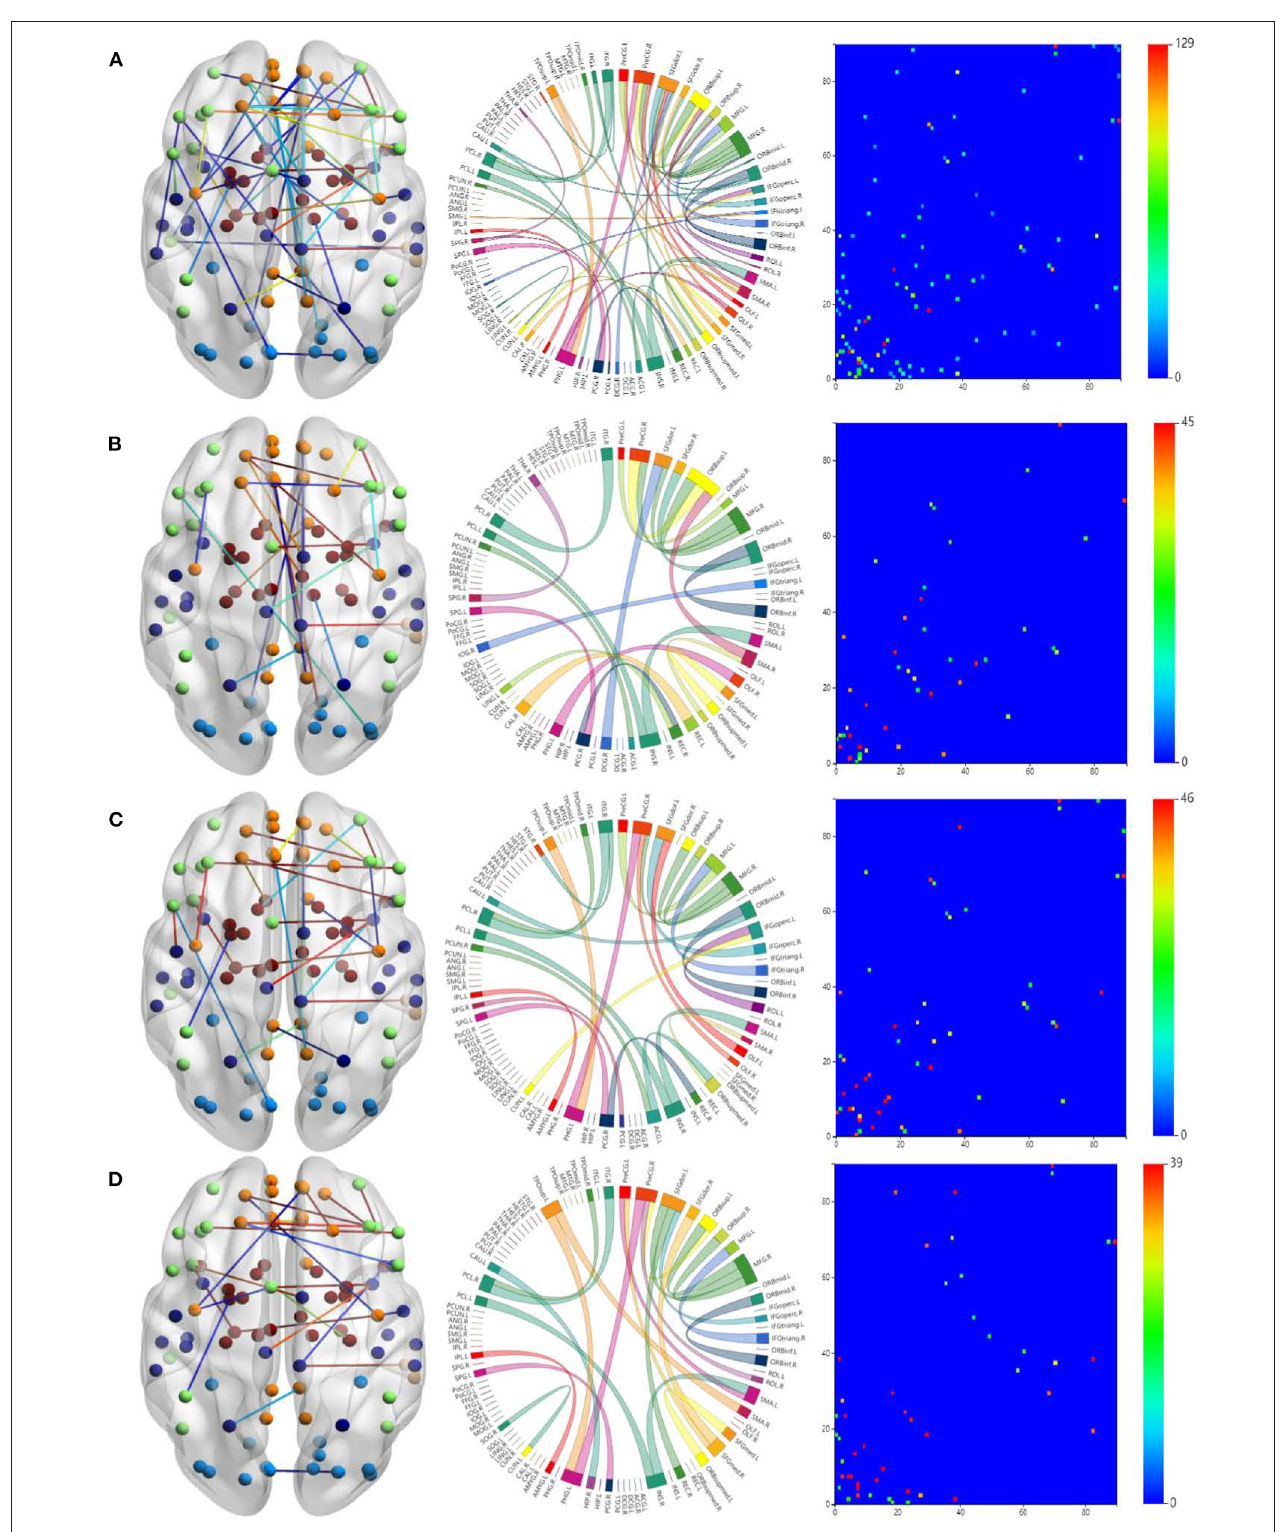
FIGURE 4 | Visualizations of the connectivity of three ND subtypes in glass brain plot graph, circle plot graph, and symmetric matrix graph on CNP dataset. (A) Shows all the ND subtypes. (B) Shows the SZ subtype. (C,D) Show the BD and ADHD subtypes, respectively.